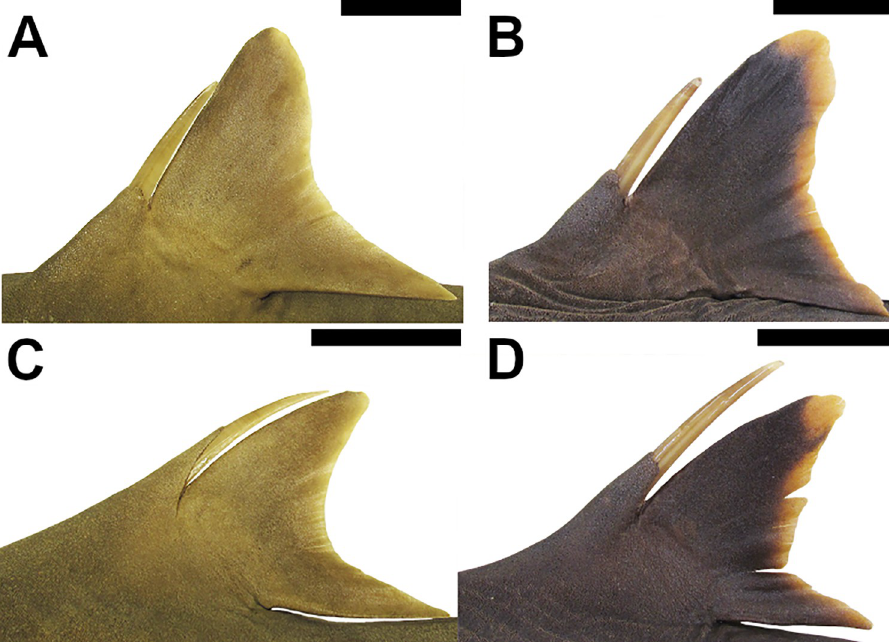
Fig 29. First (A,B) and second (C,D) dorsal fins of C . australis . A,C: AMS I 42891–001 (paratype), adult female, 1085 mm TL, Australia; B,D: NMNZ P 28732, adult female, 1189 mm TL, New Zealand. Scale bars: 20